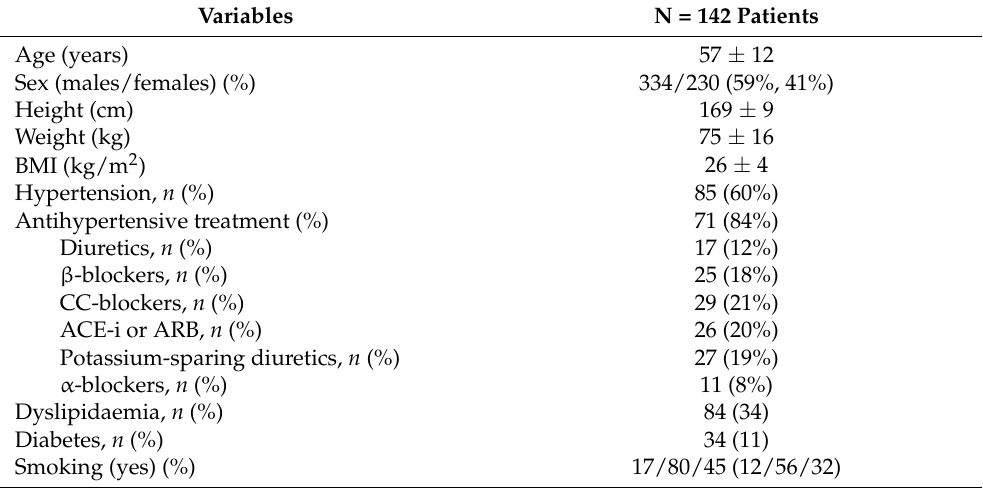
Table 1. Demographic and clinical characteristics of the population.